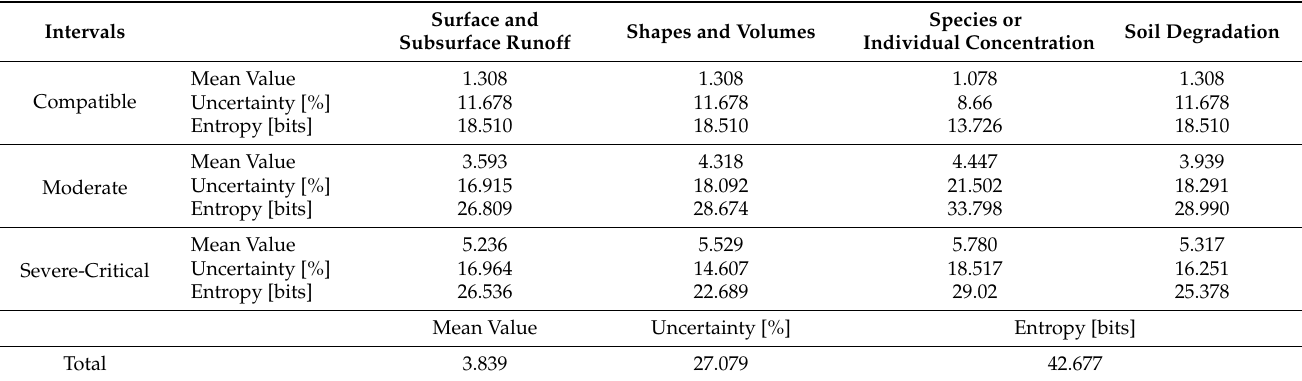
Table 3. Inference results.